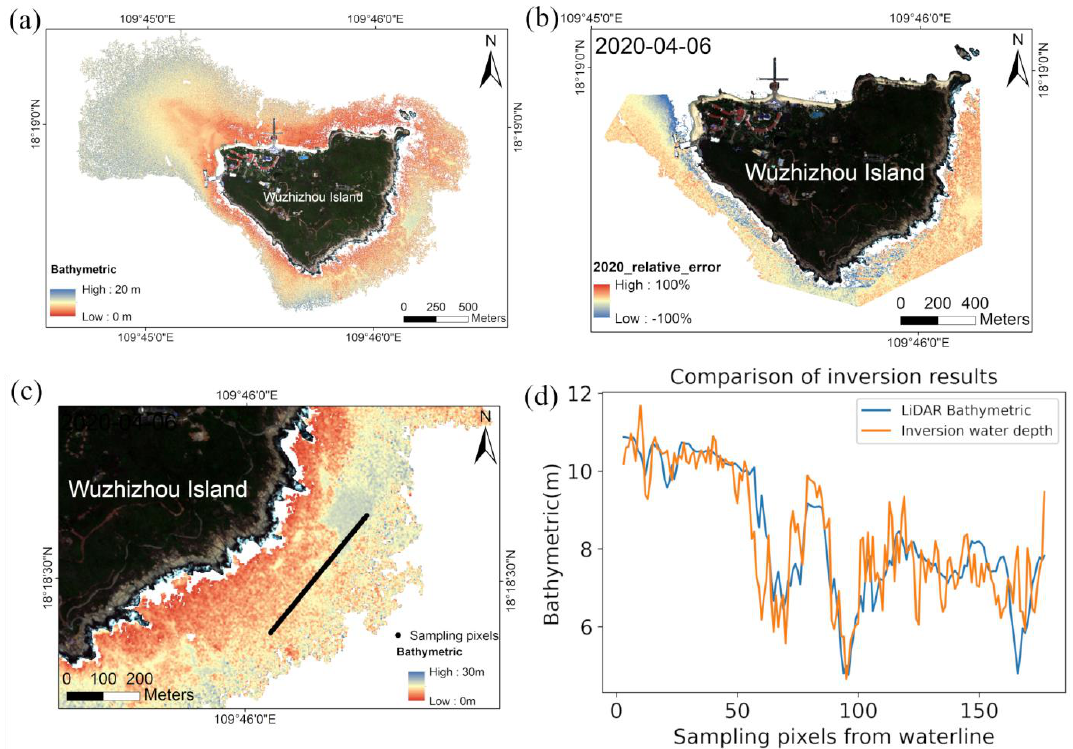
Figure 13. Comparison of remote sensing images and bathymetry inversion results in the southeastern waters of Wuzhizhou Island: ( a ) bathymetric, ( b ) relative error with east points, ( c ) sampling pixels in east area, ( d ) comparison of inversion and LiDAR.